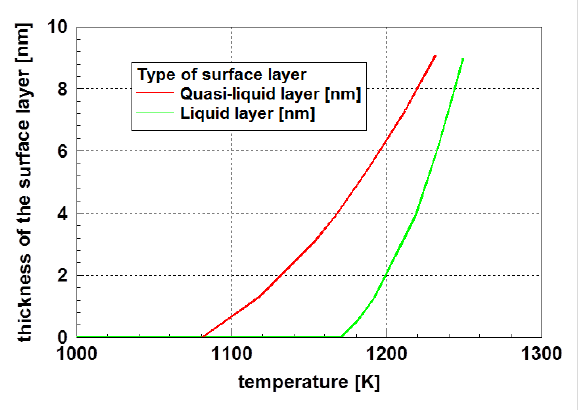
Figure 9: Thickness of the liquid and the quasi-liquid transition layer close to the surface of a 18 nm gold particle calculated by molecular dynamics [46]. The phenomenon of a layer with reduced order is restricted to temperatures not too much below the melting point of the particles. Adapted with permission from [46], copyright 2013 American Chemical